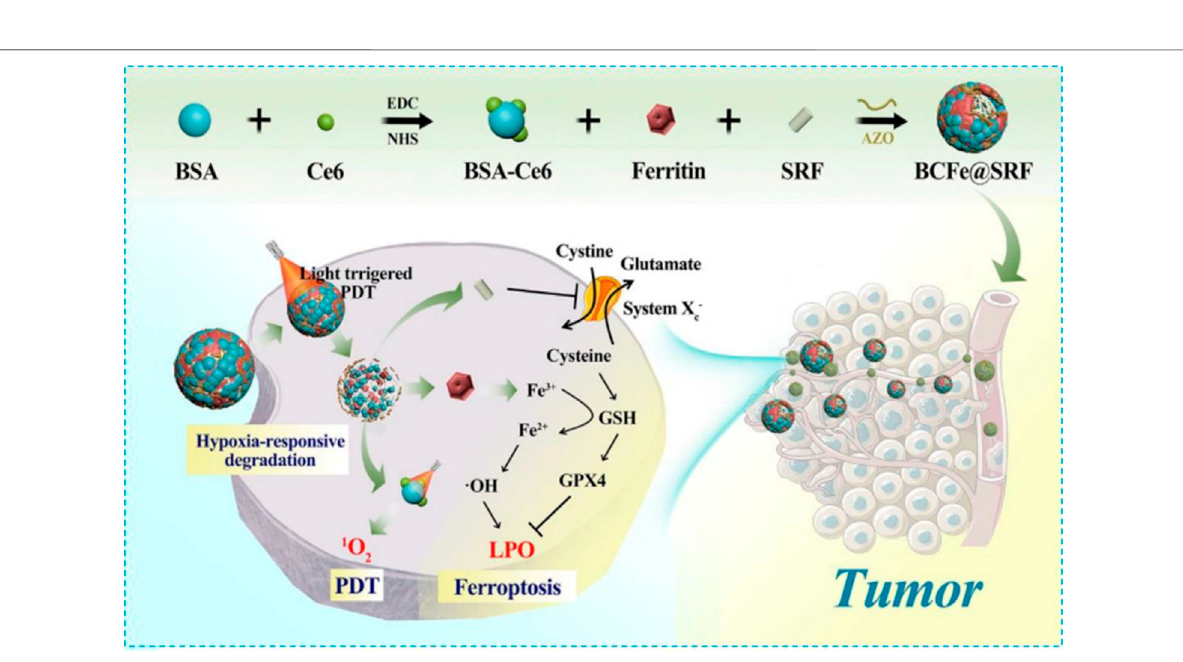
Frontiers in Chemistry |